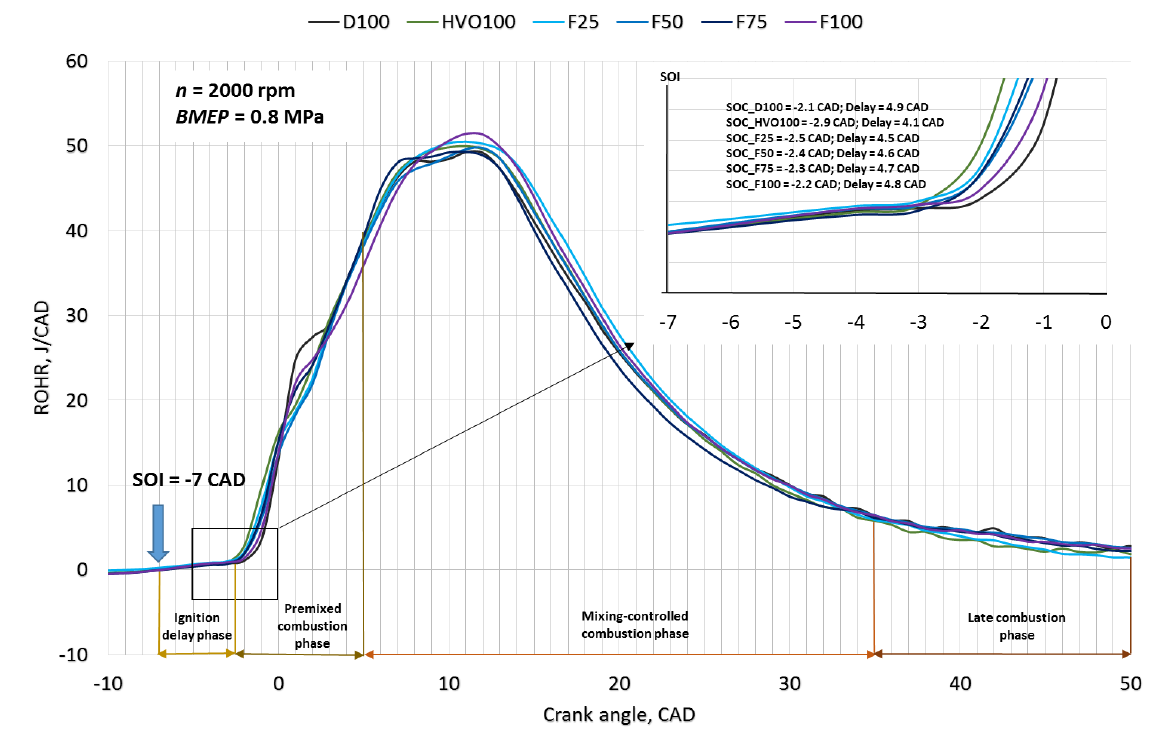
Figure 3. Dependence of the rate of heat release in the cylinder using different fuels.